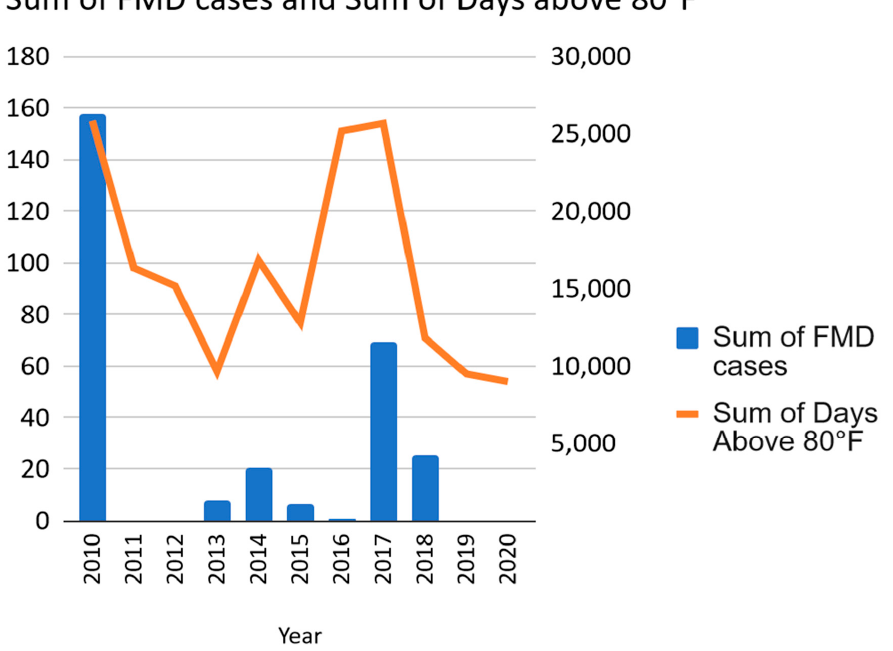
Figure 3. Graph of the number of days with temperature above 80 °F and the total number of FMD cases for Mongolia.